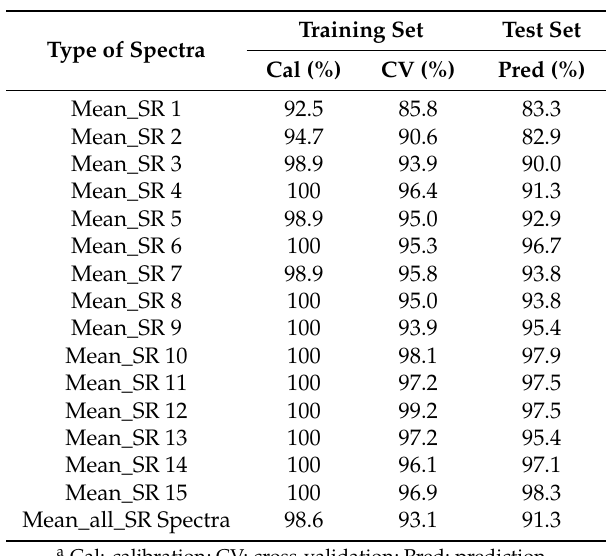
Table 2. Total classification accuracies for tomato maturity by using SVMDA for 15 mean_SR spectra and mean spectra of all SR spectra a .